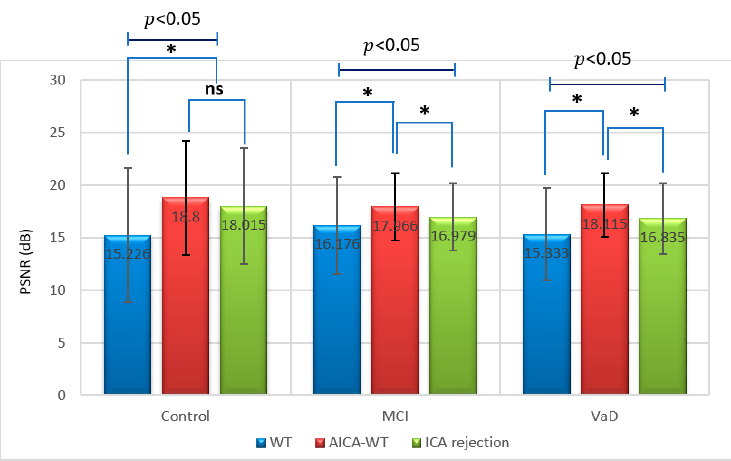
Figure 10. Comparative plot of PSNR between the artifactual EEG signals and the EEG signals after denoising using WT, AICA rejection and AICA–WT techniques for VaD, MCI patients and control subjects. *, indicates a statistically significant difference between groups ( p < 0.05). ns means not